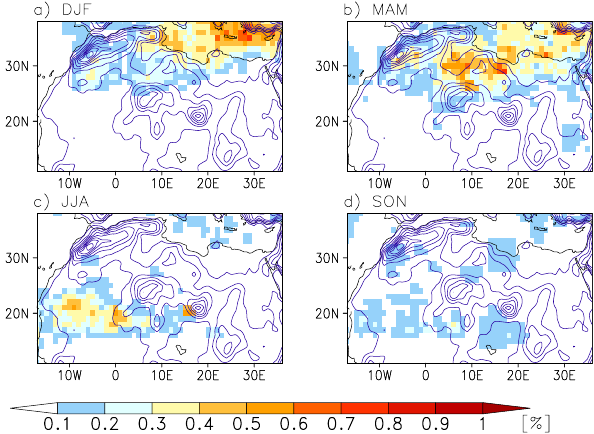
Figure 4. Track density of long-lived and migrating cyclones. Climatology of the occurrence frequency of cyclones for (a) December–February, (b) March–May, (c) June–August, and (d) September–November for 1989–2008 based on the cyclone centre defined by the outermost closed contour in the geopotential height at 925hPa from the tracking algorithm (Sect. 2.1). Contours show the orography in steps of 200m.